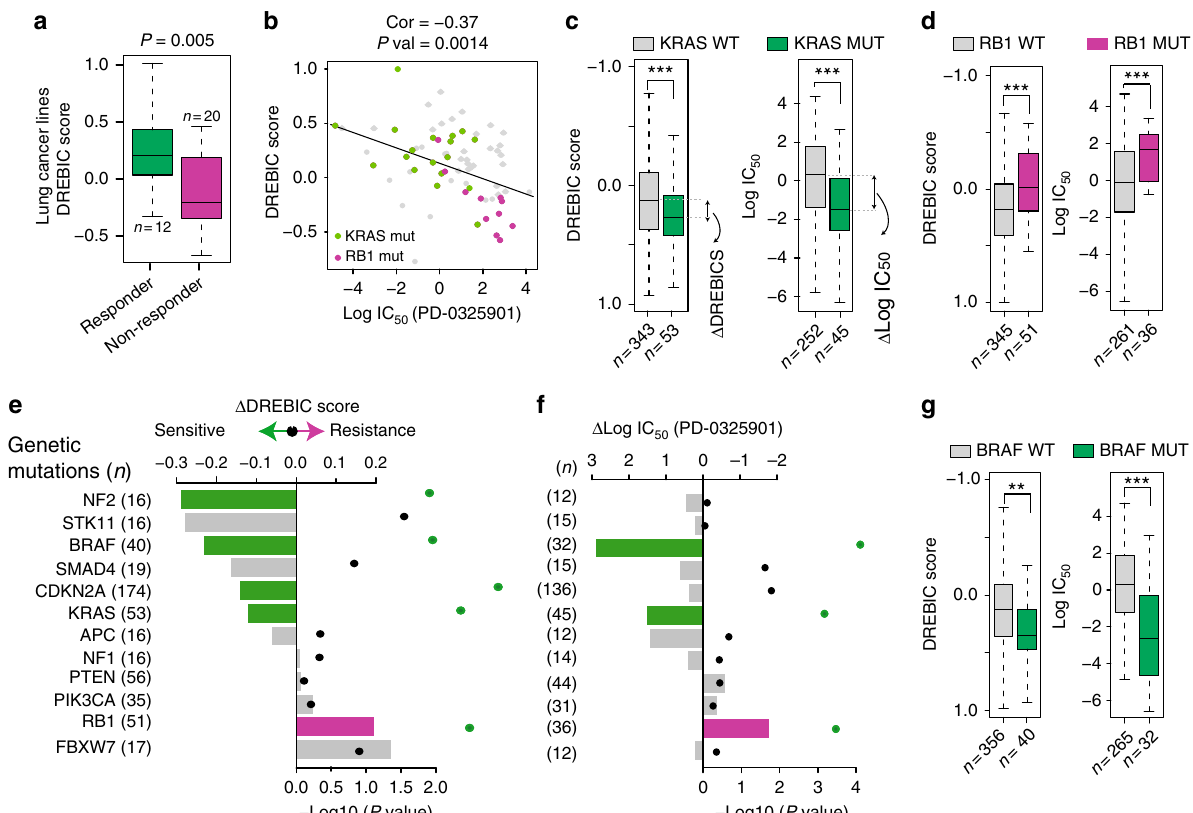
Fig. 5 DREBIC reveals genotype-speci fi c MEK inhibitor sensitivity. a Box plot showing DREBIC scores for the responder and non-responder lung cancer cell lines to MEK inhibitor (PD-0325901). b Scatter plot showing a correlation between DREBIC score and log IC 50 growth inhibition values of PD-0325901 MEK inhibitor. Cell lines with KRAS mutations are displayed as green dots and cells with RB1 mutations are displayed as magenta dots. c Box plots show the DREBIC score and log IC 50 growth inhibition due to PD-0325901 treatment in KRAS WT (gray) and KRAS mutant (green) CGP cancer cell lines. The difference in drug response and DREBIC scores between these two groups has been de fi ned as a difference between medians ( Δ DREBIC and Δ log IC 50 ). d The same analysis as performed in ( c ) has been carried out for RB1 WT and RB1 mutant cells. e Bar plot shows the difference in DREBIC score ( Δ DREBIC) between WT cell lines and mutant cell lines with indicated genes. The signi fi cance of the difference was calculated by double-sided t -test and p values are shown with dots on the right side of the panel. Bars with statistically signi fi cant differences are marked with magenta and green. f Bar plot shows the difference in median log IC 50 scores of PD-0325901 MEK inhibitor drug response ( Δ Log IC 50 ) in WT cell lines and cells with mutations in the indicated genes. The signi fi cance of the difference has been calculated as in ( e ) and p values are shown with dots on the right side of the panel. Bars with statistically signi fi cant differences are marked with magenta for positive difference and green for the negative difference. g Box plots showing the DREBIC score and log IC 50 growth inhibition due to PD-0325901 treatment in BRAF WT (gray) and mutant (green) CGP cell lines. Signi fi cance assessed by Kolmogorov – Smirnov test for all panels except ( b ). In the box plots, bounds of the box spans from 25 to 75% percentile, center line represents median, and whiskers visualize 5 and 95% of the data points. Signi fi cance is de fi ned as: **p < 0.01, ***p